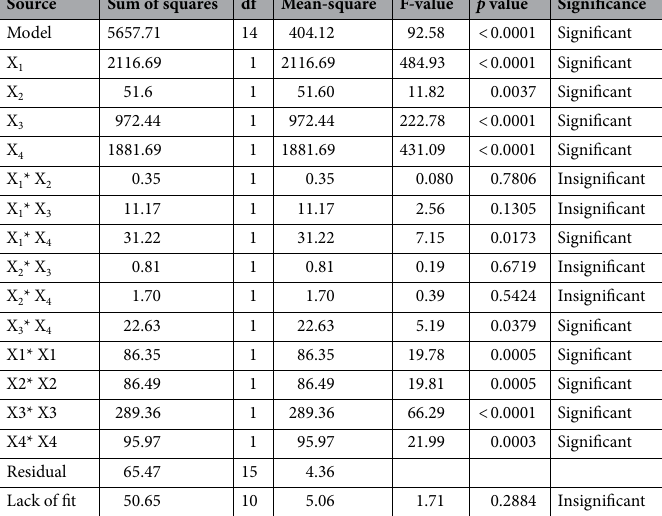
Table 3. ANOVA of RSM model.